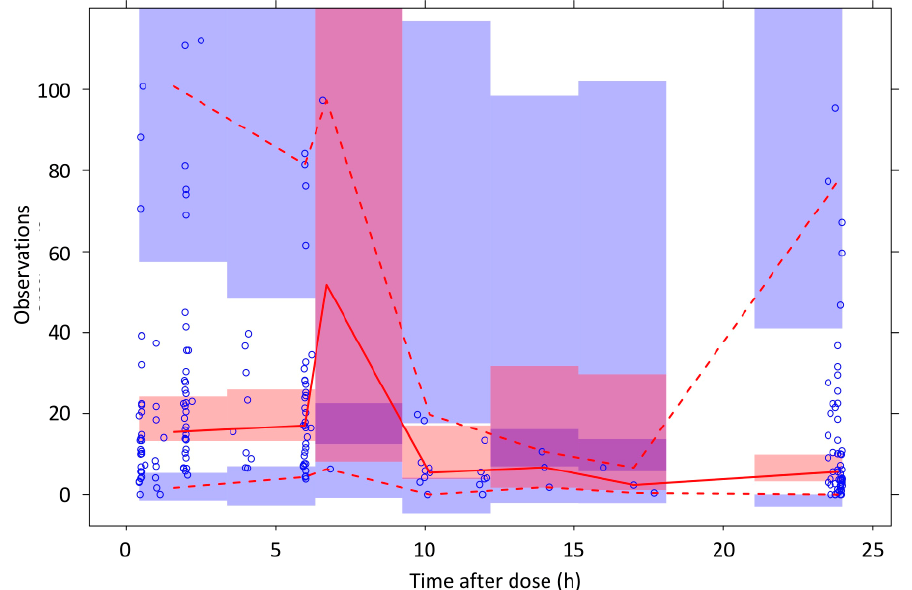
Figure 3. Visual predictive check plot for the final pharmacokinetic model obtained by resampling the original database 2000 times. Symbols, individual measured values of deferasirox plasma con- centrations; red lines, median (continuous line) and 95% confidence intervals (dashed lines) of meas- ured values; box, 95% confidence intervals of median (pink) and 95% CIs (blue).